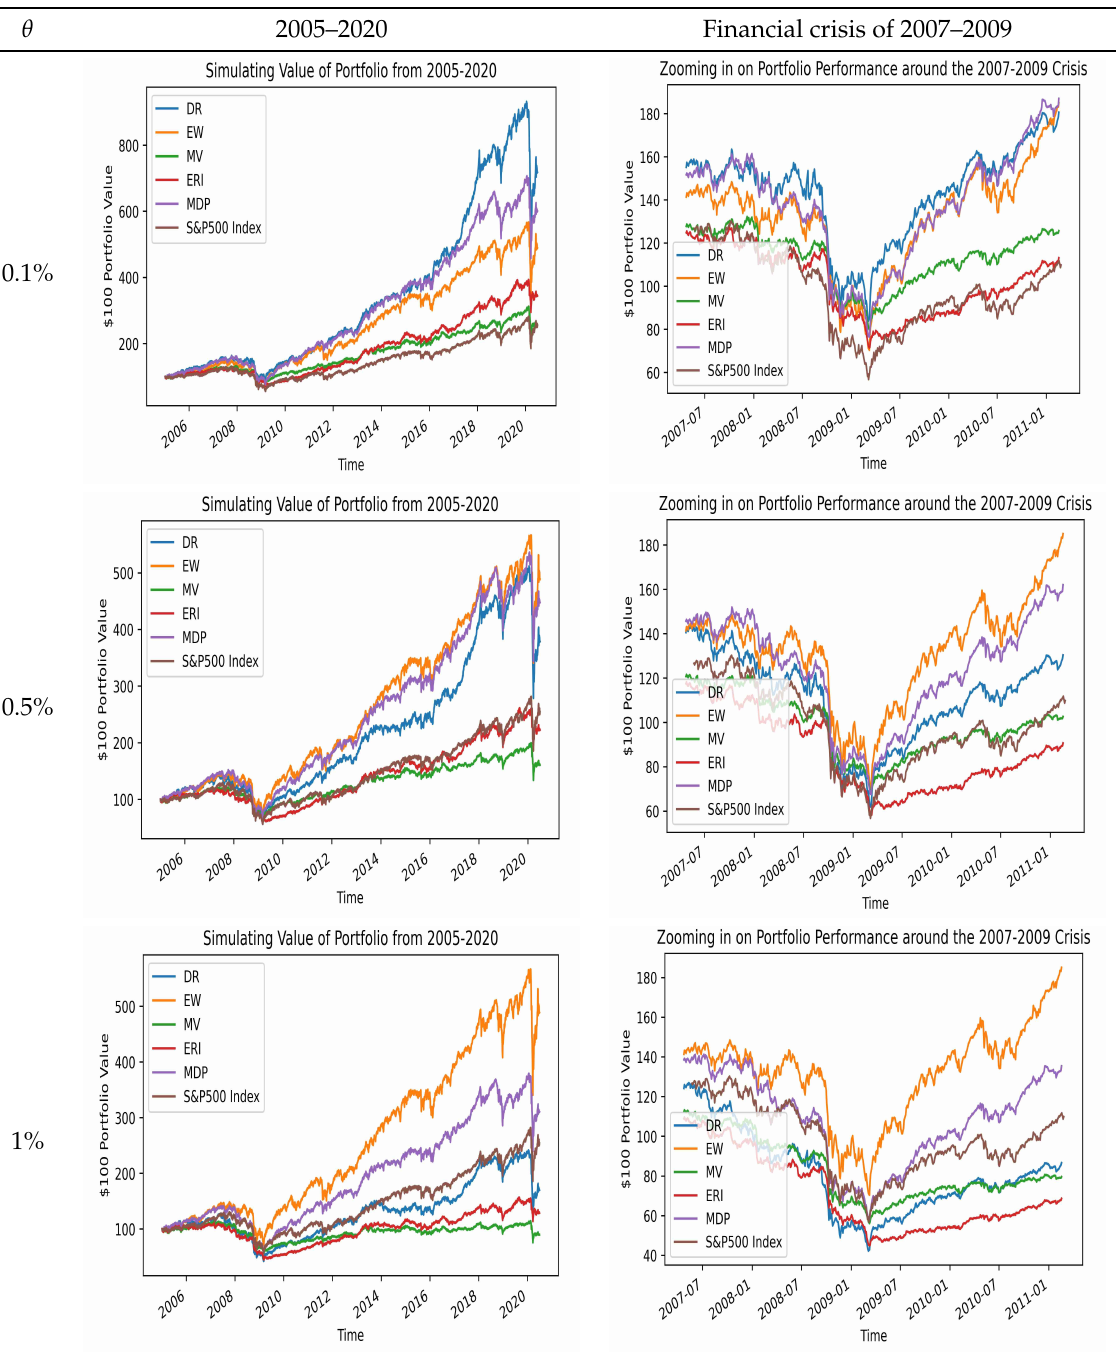
Figure A4. Portfolio values with transaction cost for grouped stocks with tail indices 2.5 < α ≤ 3.5 when θ = 0.1%,0.5%,1%, θ fc = 1.5 θ